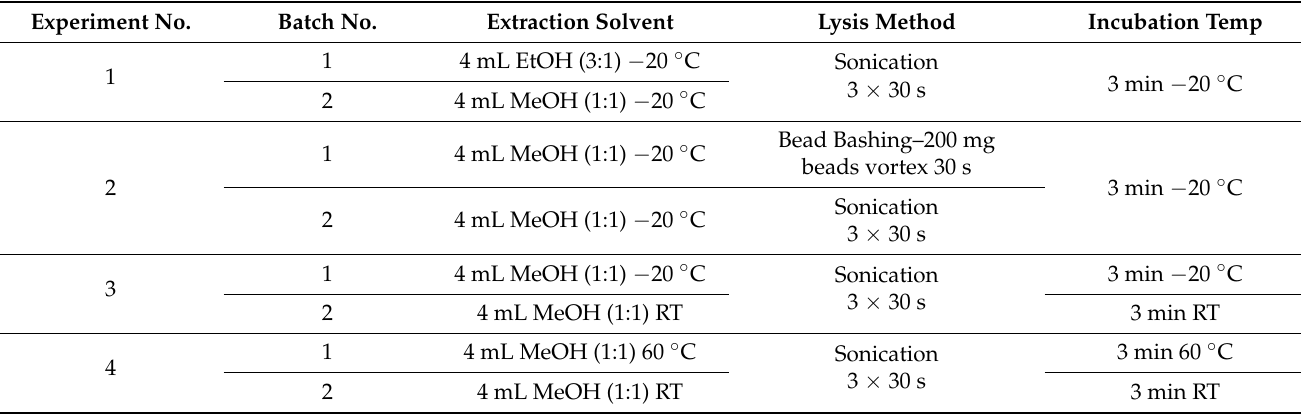
Table 1. Conditions of each experiment used to determine the best lysis method, incubation temperature and extrac- tion solvent. Experiment